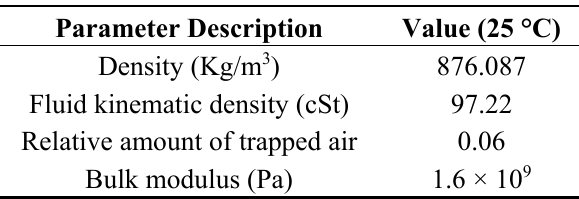
Table 9. Hydraulic fluid